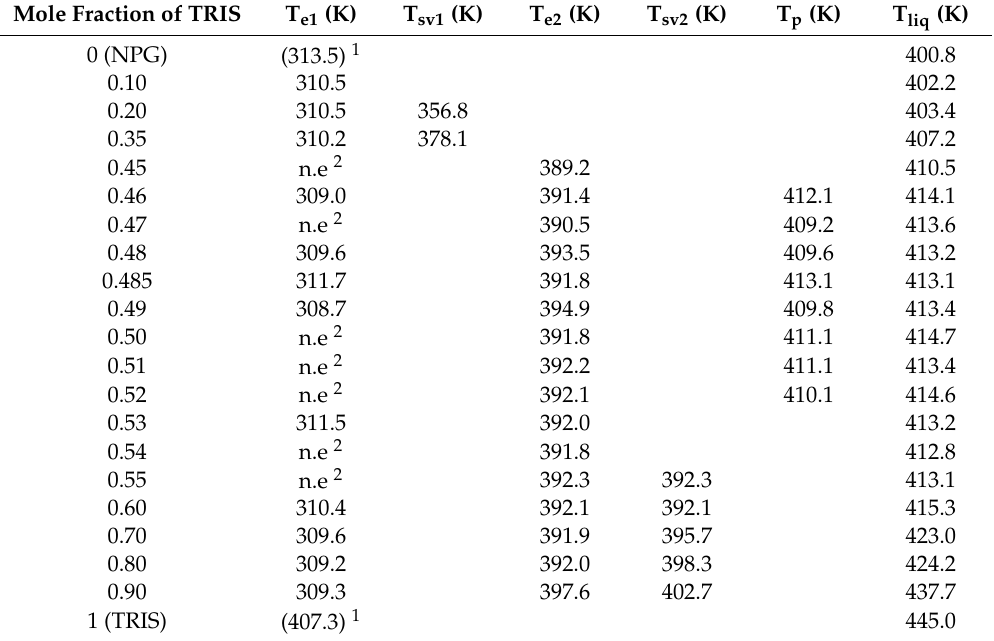
Table 3. Characteristic temperatures for the di ff erent phase transitions in the NPG-TRIS system: T e1 , eutectoid invariant [M + O + C F ]; T sv1 , first superior solvus corresponding to the change [O + C F